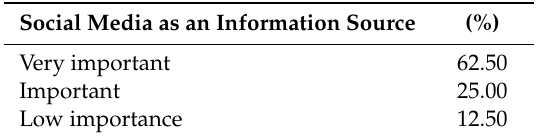
Table 6. Social media as an information source in your work.